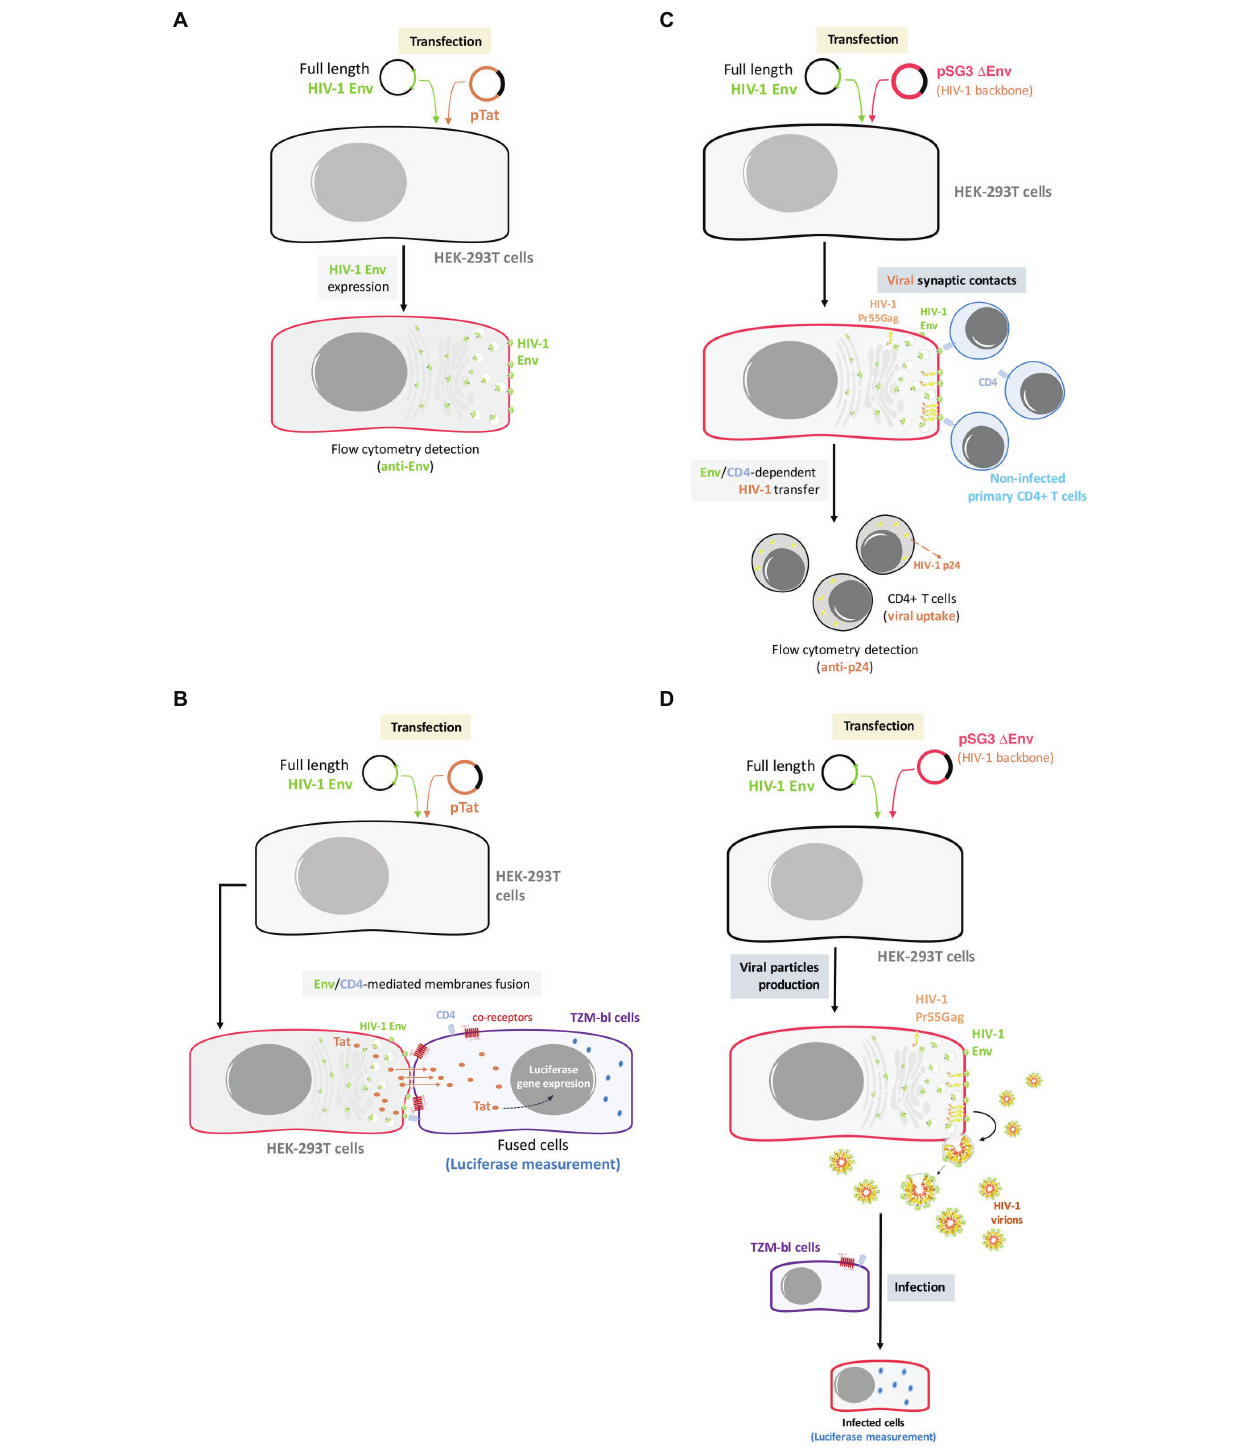
FIGURE 1 | Outline of the experimental model used for the analysis of Env expression, Env-mediated cell-to-cell fusion, viral transfer, and viral infectivity. (A) Env expression: HEK-293T cells will be co-transfected with primary or reference full-length viral env and a ptat Δ env HIV-1 expression plasmid, allowing Env cell-surface expression in a viral production context. Cell-surface Env expression will be then analyzed by flow cytometry using specific anti-Env antibody. (B) Env-mediated fusion activity: effector HEK-293T cells producing HIV-1 particles bearing primary or reference Envs will be co-cultured with TZM-bl cells to force synapsis formation and CD4-mediated binding of budding particles to target cells. (C) Env-mediated viral transfer: HEK-293T cells producing HIV-1 particles carrying primary or reference Envs will be co-cultured with primary CD4 + T cells. Then, HIV-1 transfer will be analyzed by flow cytometry using specific anti-p24 antibody in target CD4 + T cells. (D) Env-mediated viral infection: TZM-bl cells will be infected with serial dilutions of viral particles obtained from transfected HEK-293T carrying the different primary or reference HIV-1 Envs. After 48 h, infectivity capacity will be analyzed by quantifying luciferase assay in infected TZM-bl